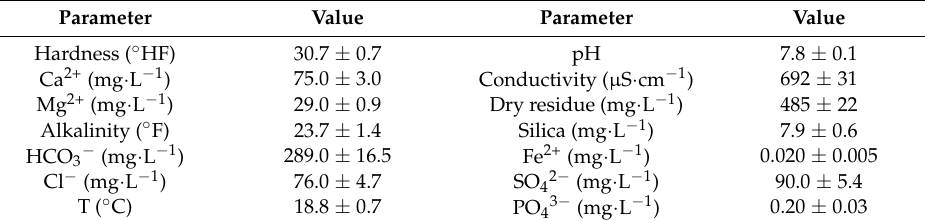
Table 4. Characterization of the water used in the paper production process.